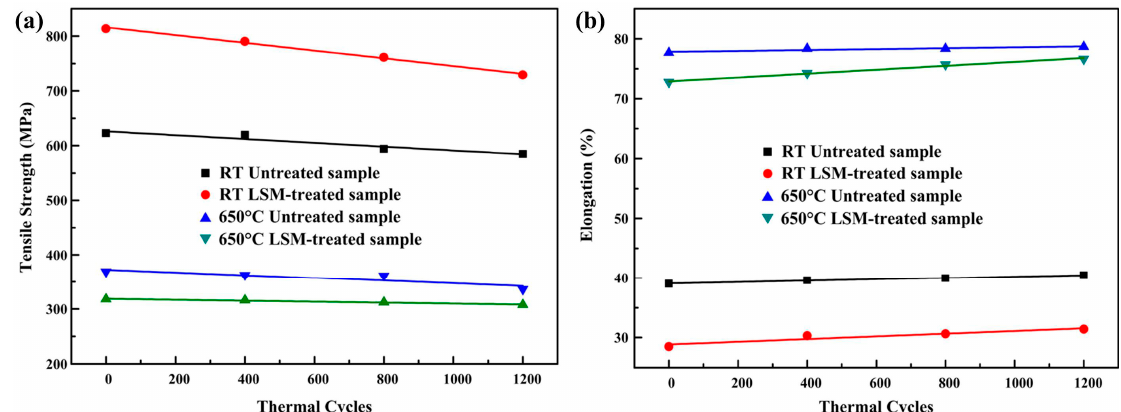
Figure 11. Strength ( a ) and elongation ( b ) of LSM-treated specimen and untreated specimen versus thermal fatigue cycles.